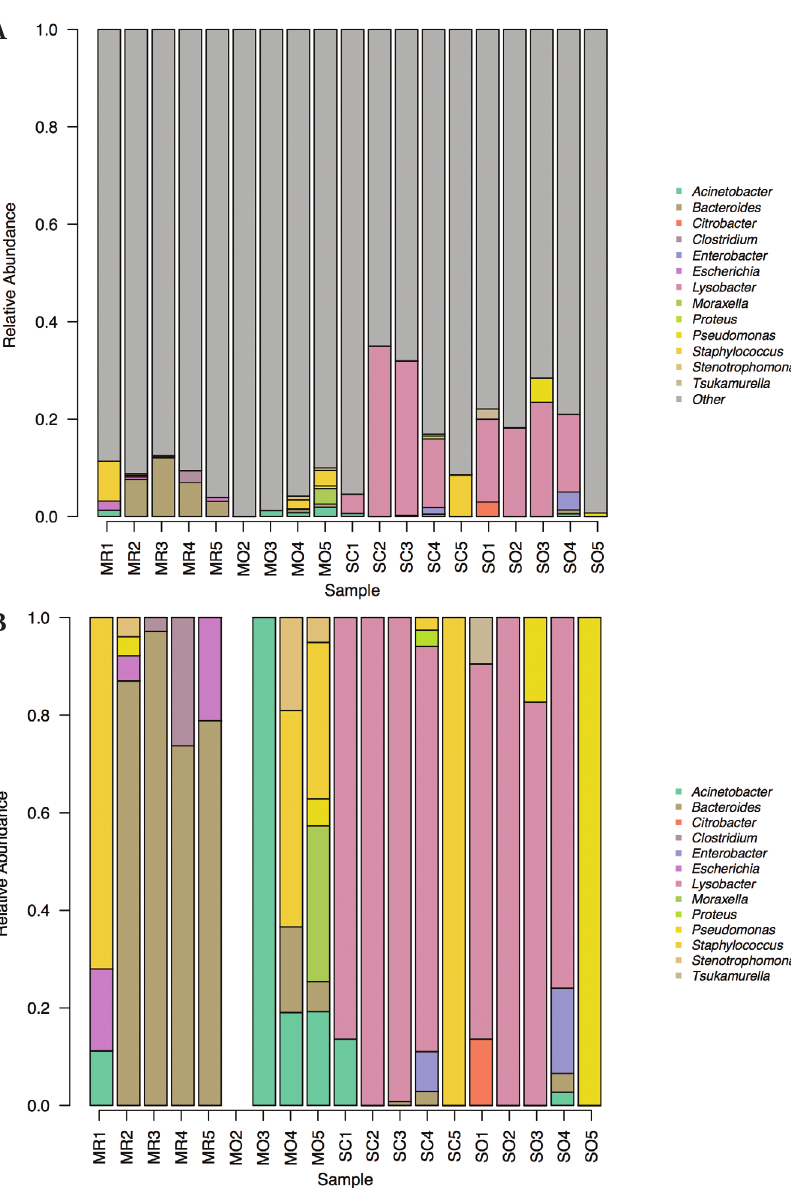
Figure 1. A Relative abundance of bacteria genera identified in samples taken from mice and ball pythons ( Python regius ) at a python farm in Togo. Genera containing potential pathogens of known zoonotic concern to ball pythons (as reported in the scientific literature) are highlighted in colour. The majority of reads (shown in grey) were assigned to “other” least concern groups, which consisted of ASVs that were either assigned to non-target genera or no genus. Samples were from swabs of: MR – mouse rectal; MO – mouse oral, SC – snake cloacal; and SO – snake oral. B Relative abundance of bacteria genera of known zoonotic concern to ball pythons ( Python regius ) (as reported in the scientific literature) identified in samples taken from mice and snakes at a python farm in Togo. Samples were from swabs of: MR – mouse rectal; MO – mouse oral, SC – snake cloacal; and SO – snake oral. No bacterial genera of zoonotic concern were identified from sample